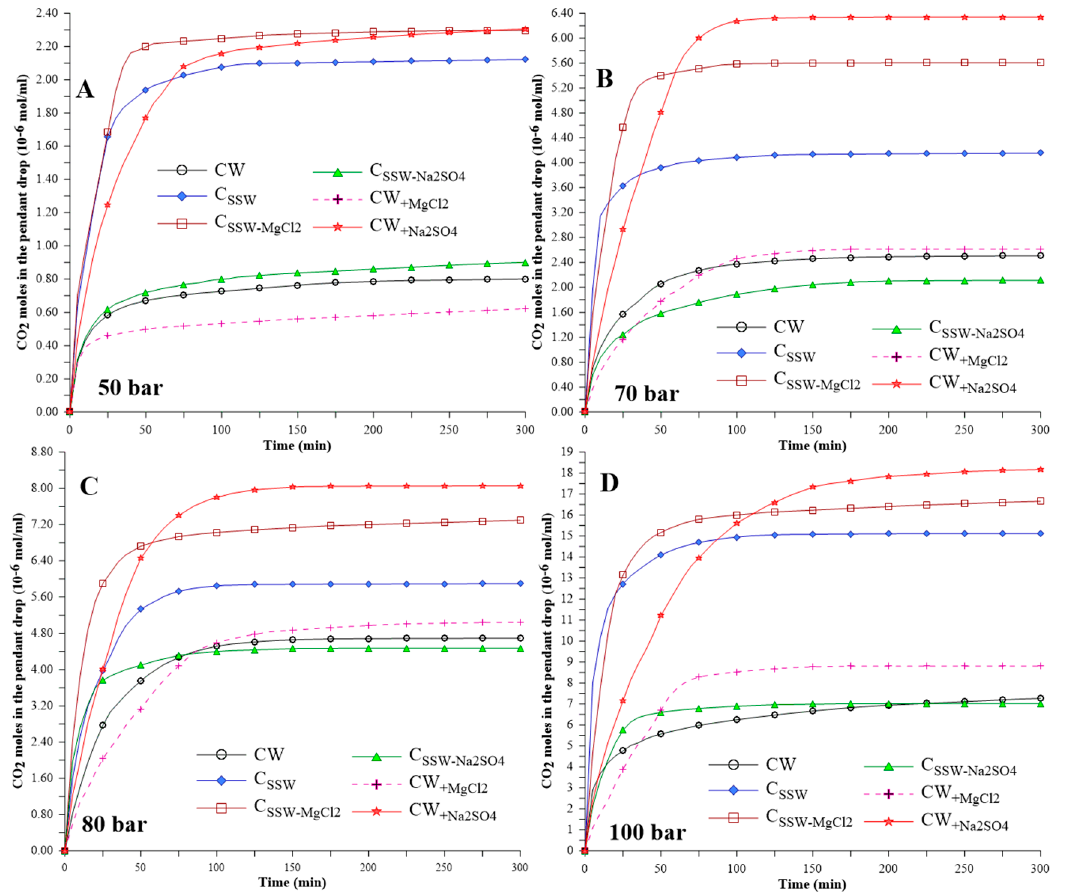
Figure 3. Mass of CO 2 transferred into the n-decane drop (mole/ml) from the start of the experiment till equilibrium for 50 bar ( a ), 70 bar ( b ), 80 bar ( c ), and 100 bar ( d ).